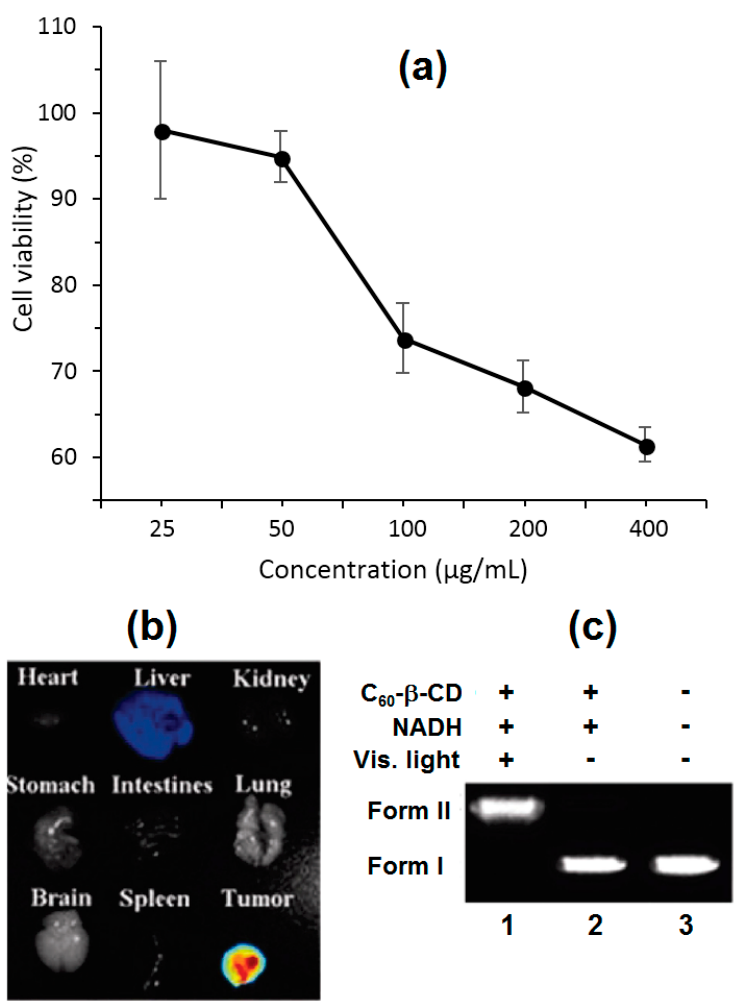
Figure 74. ( a ) In vitro cytotoxicity of C 60 - β -CD against human neuroblastoma SH-SY5Y cells upon visible light for 20 min. ( b ) Near Infrared Fluorescence (NIRF) images of different organs at 96 h after tail-vein injection of the NIR-797-labeled C 60 - β -CD. ( c ) Photoinduced DNA cleavage behavior of C 60 - β -CD. The pBR322 supercoiled plasmid was incubated with each chemical for 4 h at room temperature. Lane 1: pBR322 DNA (0.017 µ g/ µ L) with C 60 - β -CD (33 µ mol/L), NADH (330 µ mol/L), incubated under visible light irradiation. Lane 2: pBR322 DNA (0.017 µ g/ µ L) with C 60 -CD (33 µ mol/L), NADH (330 µ mol/L), incubated in dark. Lane 3: pBR322 DNA (0.017 µ g/ µ L) incubated in the dark. Reproduced and adapted by permission of The John Wiley and Sons